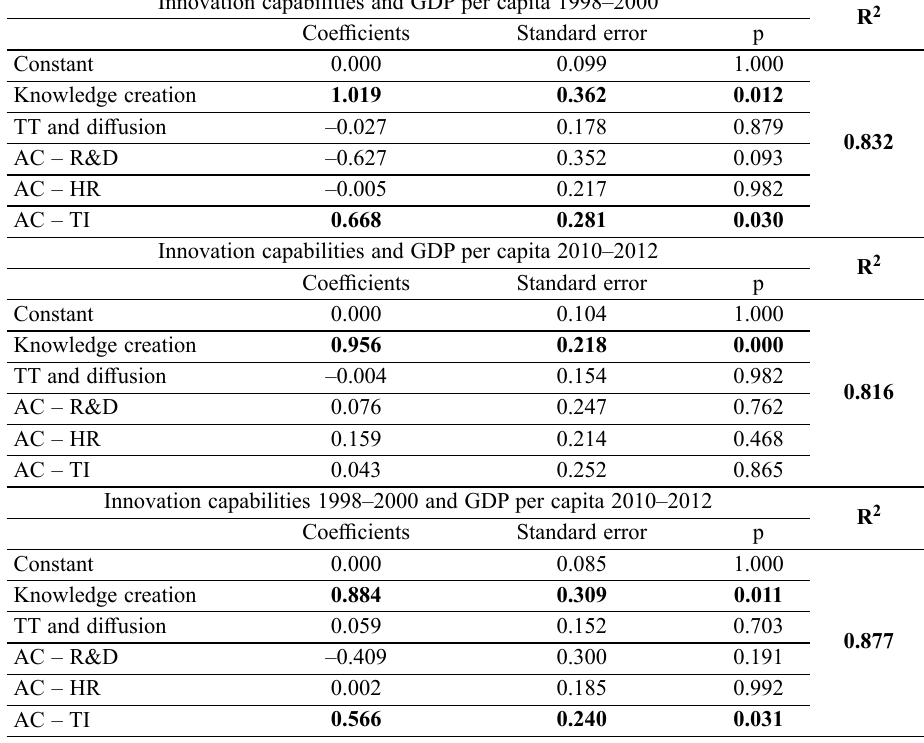
Table 2. Linear regression analysis between GDP per capita and five innovation capabilities’